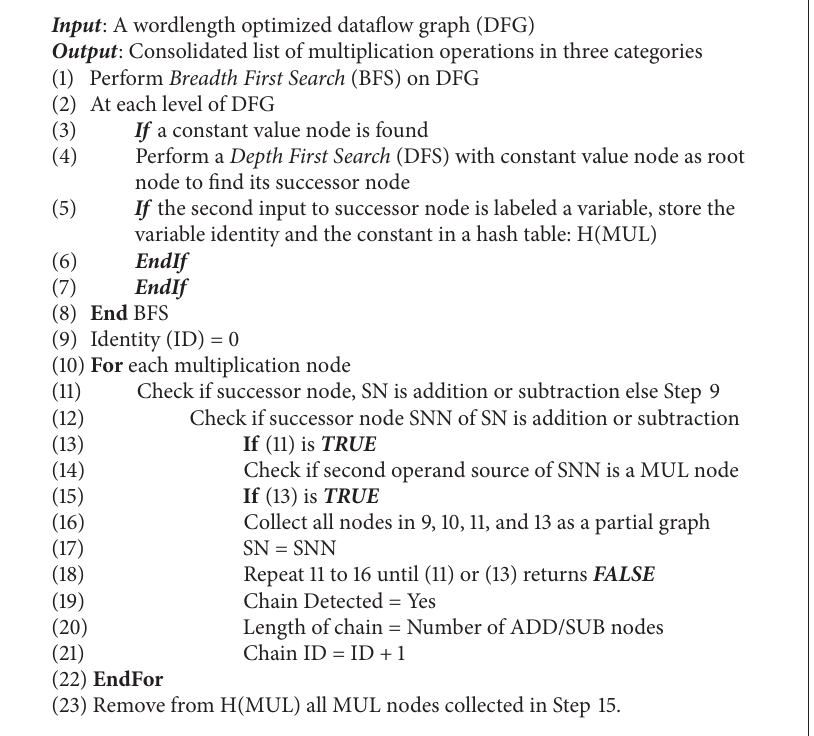
Algorithm 1: Autoidentify algorithm for identification of multiplication and allied operations.